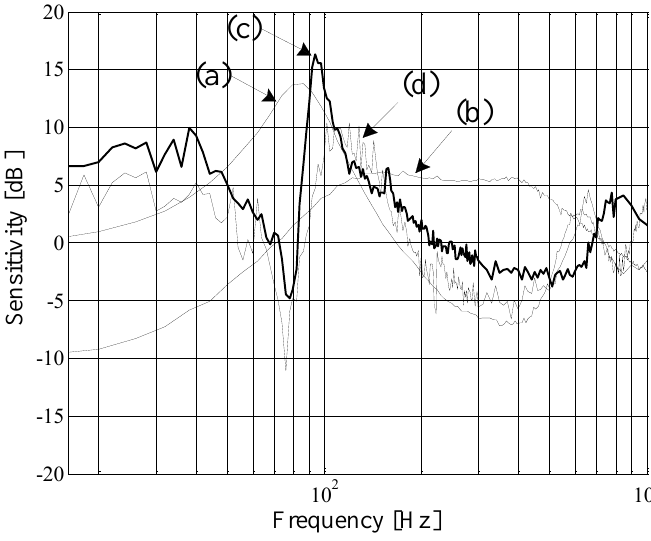
Figure 14. Simulated and experimental input sensitivity functions.